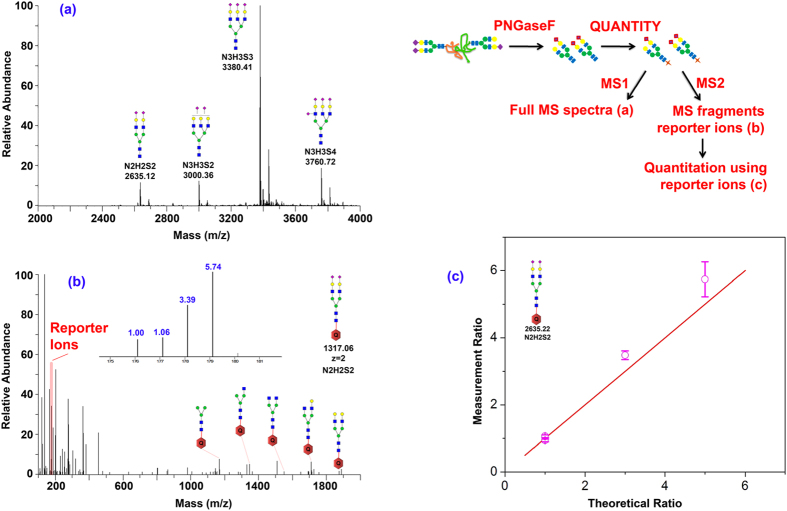
Efficiency and linear range of glycan labeling with QUANTITY.N-Glycans extracted from bovine fetuin are prepared in a ratio of 1:1:3:5 prior to labeling with QUANTITY via reduction amination. The labeled fetuin glycans (m/z at 176, 177, 178, and 179), sialylated glycans, including N2H2S2, N3H3S2, N3H3S3, and N3H3S4, are pooled for electrospray (ESI) – tandem mass spectrometry (MS2) (note: core structure N2H3 is not included in the composition). (a) MS spectrum of fetuin N-glycans. (b) MS2 spectra of N2H2S2 consist of glycan fragmentation and QUANTITY reporter ions. (c) Linear range of glycan-QUANTITY labeling at a ratio of 1:1:3:5. Error bar were obtained from three independent experiments.